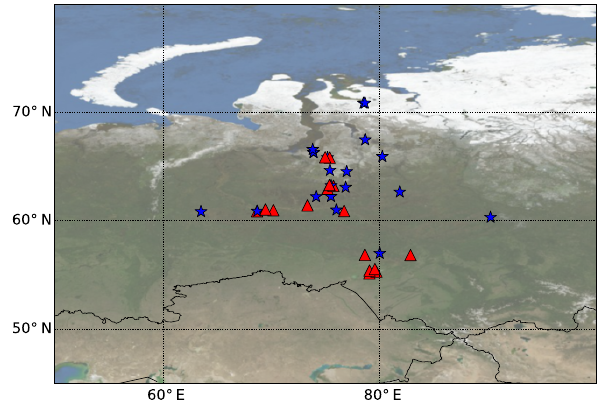
Figure 5. 36 sites of vegetation green biomass and NPP. Triangles in red: sites with NVPs, grasses and shrubs at the same location, stars in blue: sites with only